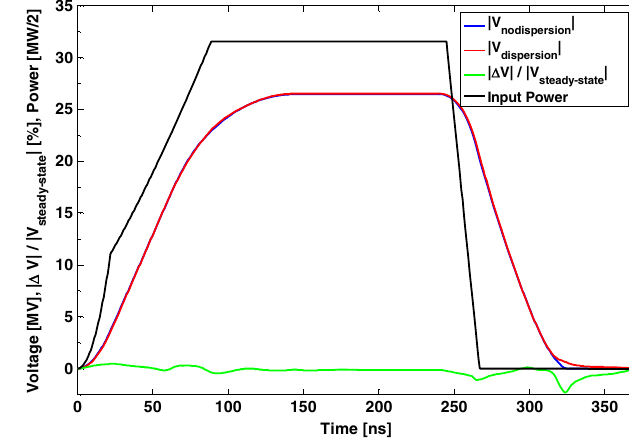
FIG. 2. Complex magnitudes of the frequency response for the port excitation (red) and beam coupling impedance (blue).